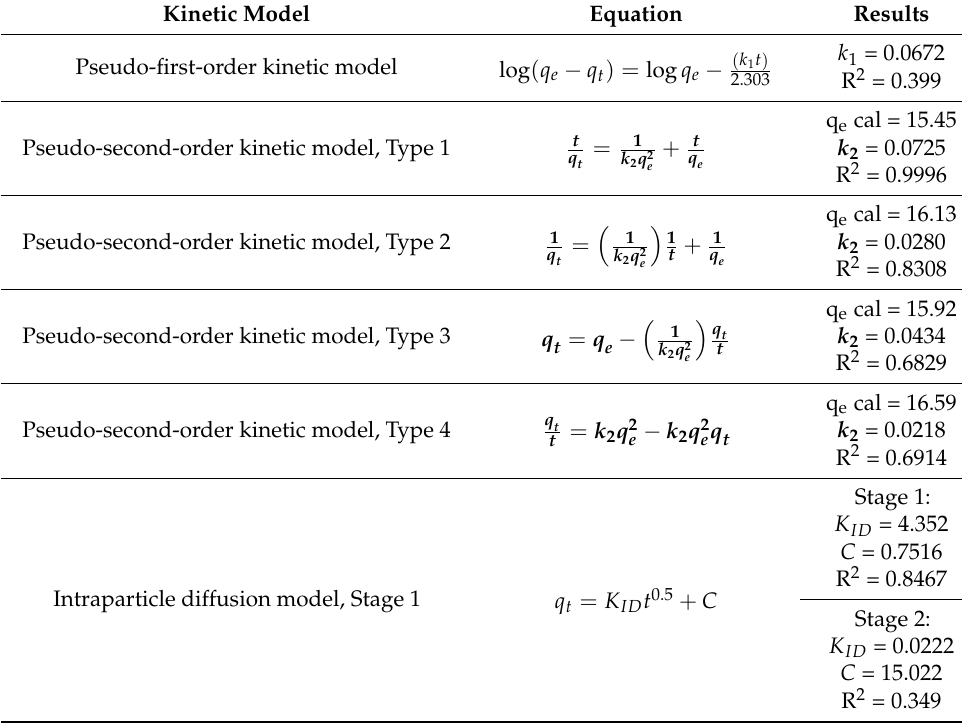
Table 5. Kinetic parameters of the investigated